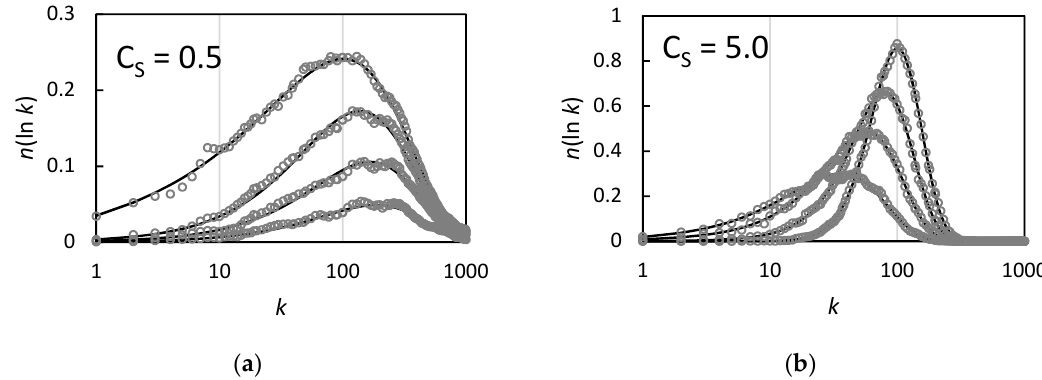
Figure 1. Comparison of calculated CLDs (solid lines) with simulated distributions (open circles, 10,000 chains) for polymerizations with T = 100, C S = 0.5 ( a ) or 5 ( b ), conversion = 0.25, 0.5, 0.75 and 1.